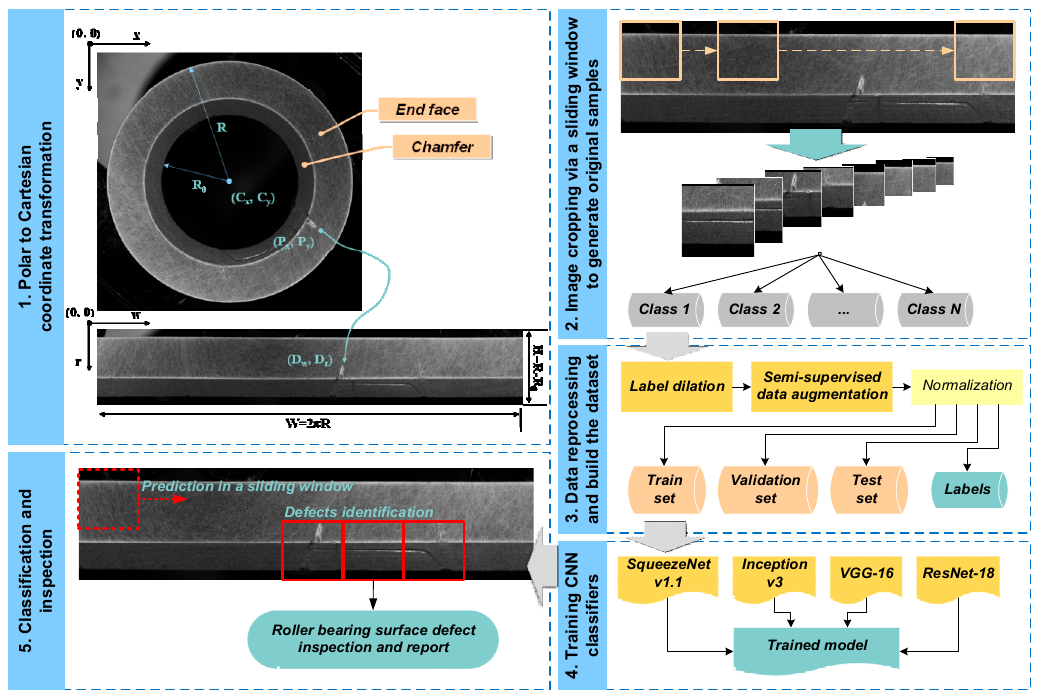
Figure 1. Framework and flowchart of proposed small data-driven convolution neural network (SDD- CNN) for roller defect inspection. (SDD-CNN) for roller defect